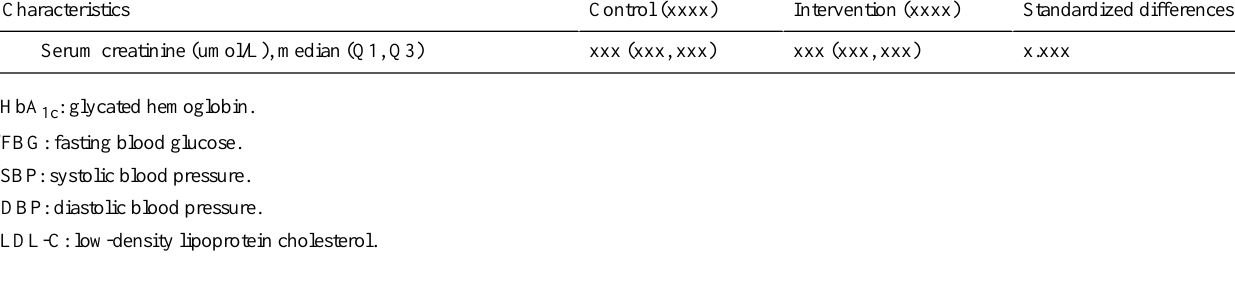
Table 2. Estimated effects of intervention compared to control on primary and secondary binary outcomes at end of study.